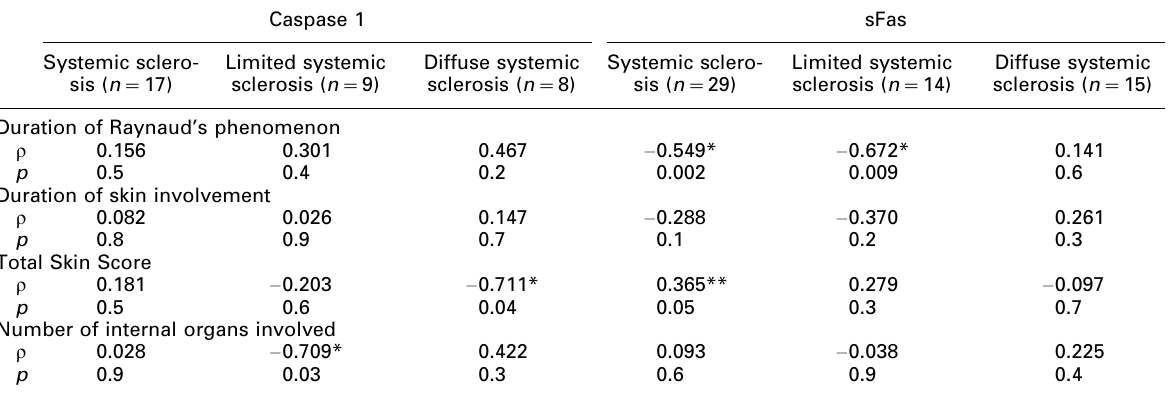
Table 4. Correlation between caspase 1 and sFas serum levels and duration of Raynaud’s phenomenon, duration of skin involvement, Total Skin Score and number of internal organs involved in 29 examined patients with systemic sclerosis Caspase 1 sFas Limited systemic Diffuse systemic Systemic sclero- Limited systemic Diffuse systemic Systemic sclero- sclerosis (n (cid:3) / 9) sclerosis (n (cid:3) / 8) sis (n (cid:3) / 29) sclerosis (n (cid:3) / 14) sclerosis (n (cid:3) / 15) sis (n (cid:3) / 17) Duration of Raynaud’s phenomenon r